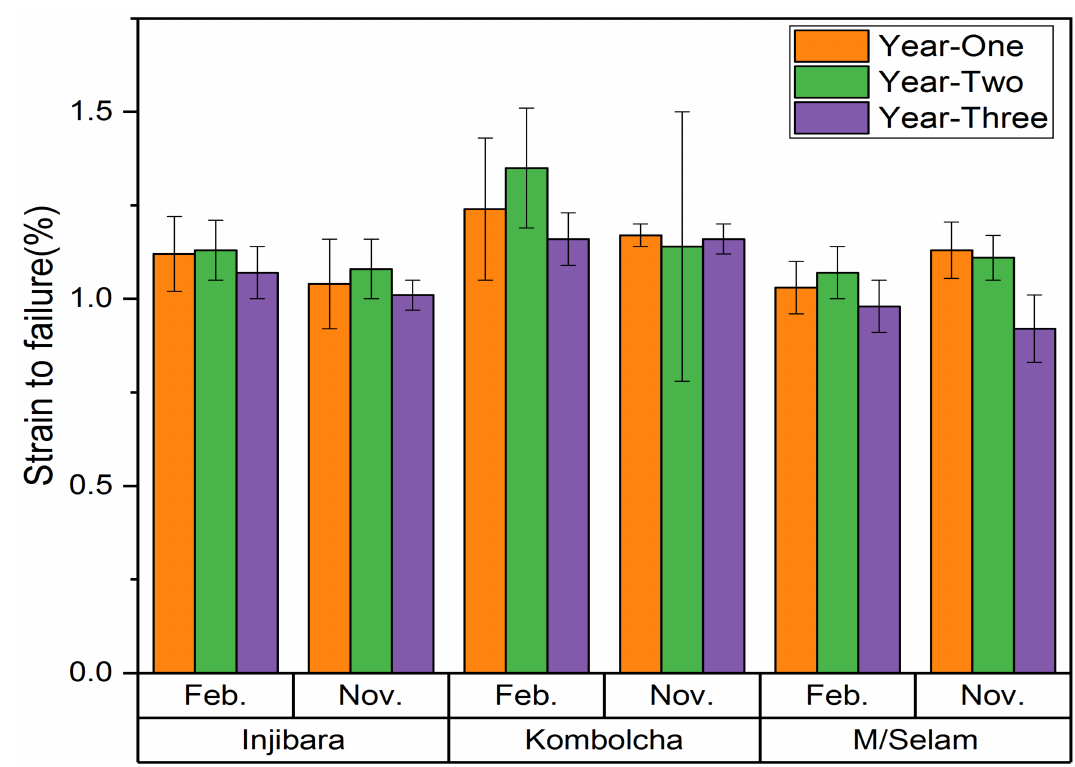
Figure 7. Strain to failure results using